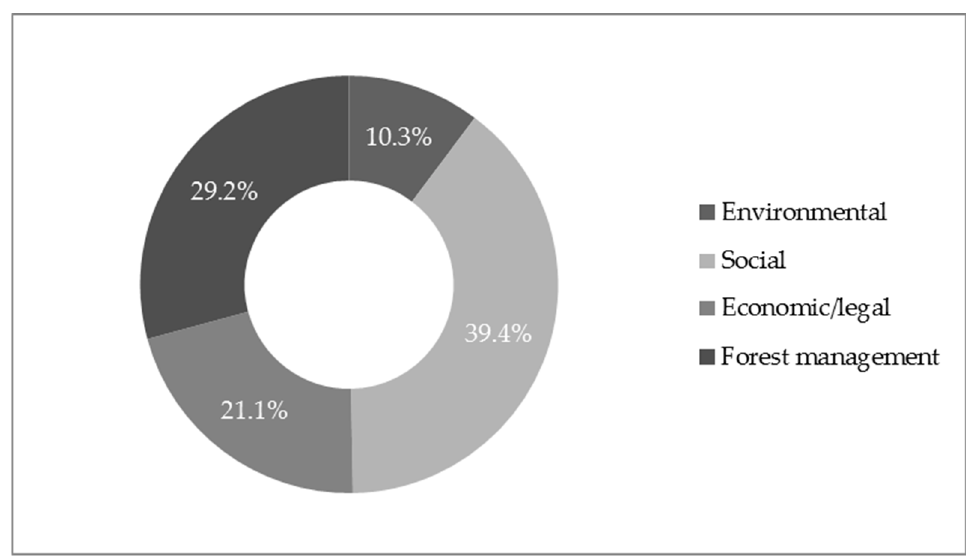
Figure 4. The distribution of non-conformities by meta-categories.